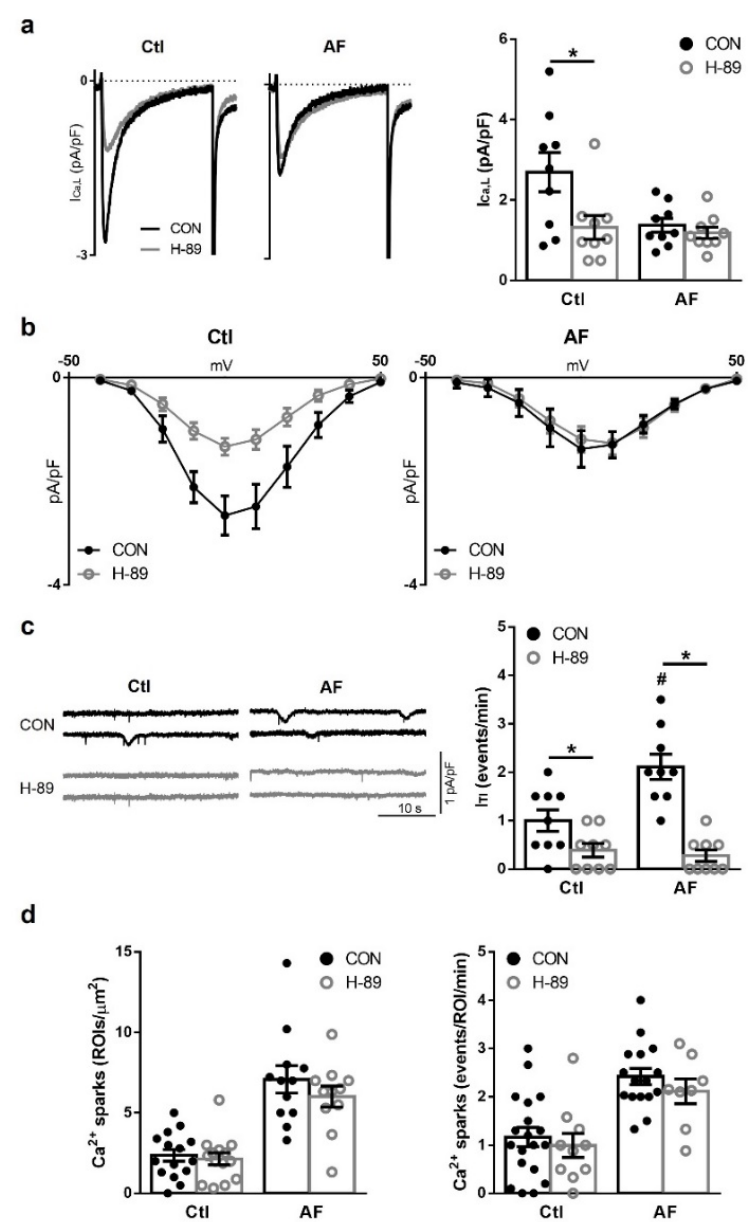
Figure 1. Effect of protein kinase A (PKA) inhibition on I Ca,L , I TI and sarcoplasmic reticulum (SR) Ca 2+ load. ( a ) ( left ): Representative I Ca,L recordings in myocytes from a patient in sinus rhythm (Ctl) and a patient with atrial fibrillation (AF) before (CON, black trace) and after exposure to the selective PKA inhibitor (H-89, 10 µ M, grey trace). ( right ): Average effect of H-89 in Ctl and AF patients. ( b ) Mean effect of H-89 on the current-voltage relationship in Ctl and AF patients. ( c ) ( left ): Representative traces of spontaneous I TI recorded in Ctl and AF myocytes before and after exposure to H-89. ( right ): Mean effects of H-89 on the spontaneous I TI frequency in Ctl and AF patients. ( d ) Average effects of H-89 on Ca 2+ sparks density ( left ) and frequency ( right ) before and after exposure to H-89. ROI: region of interest. Significant differences between treatments are indicated with * and between groups with #.